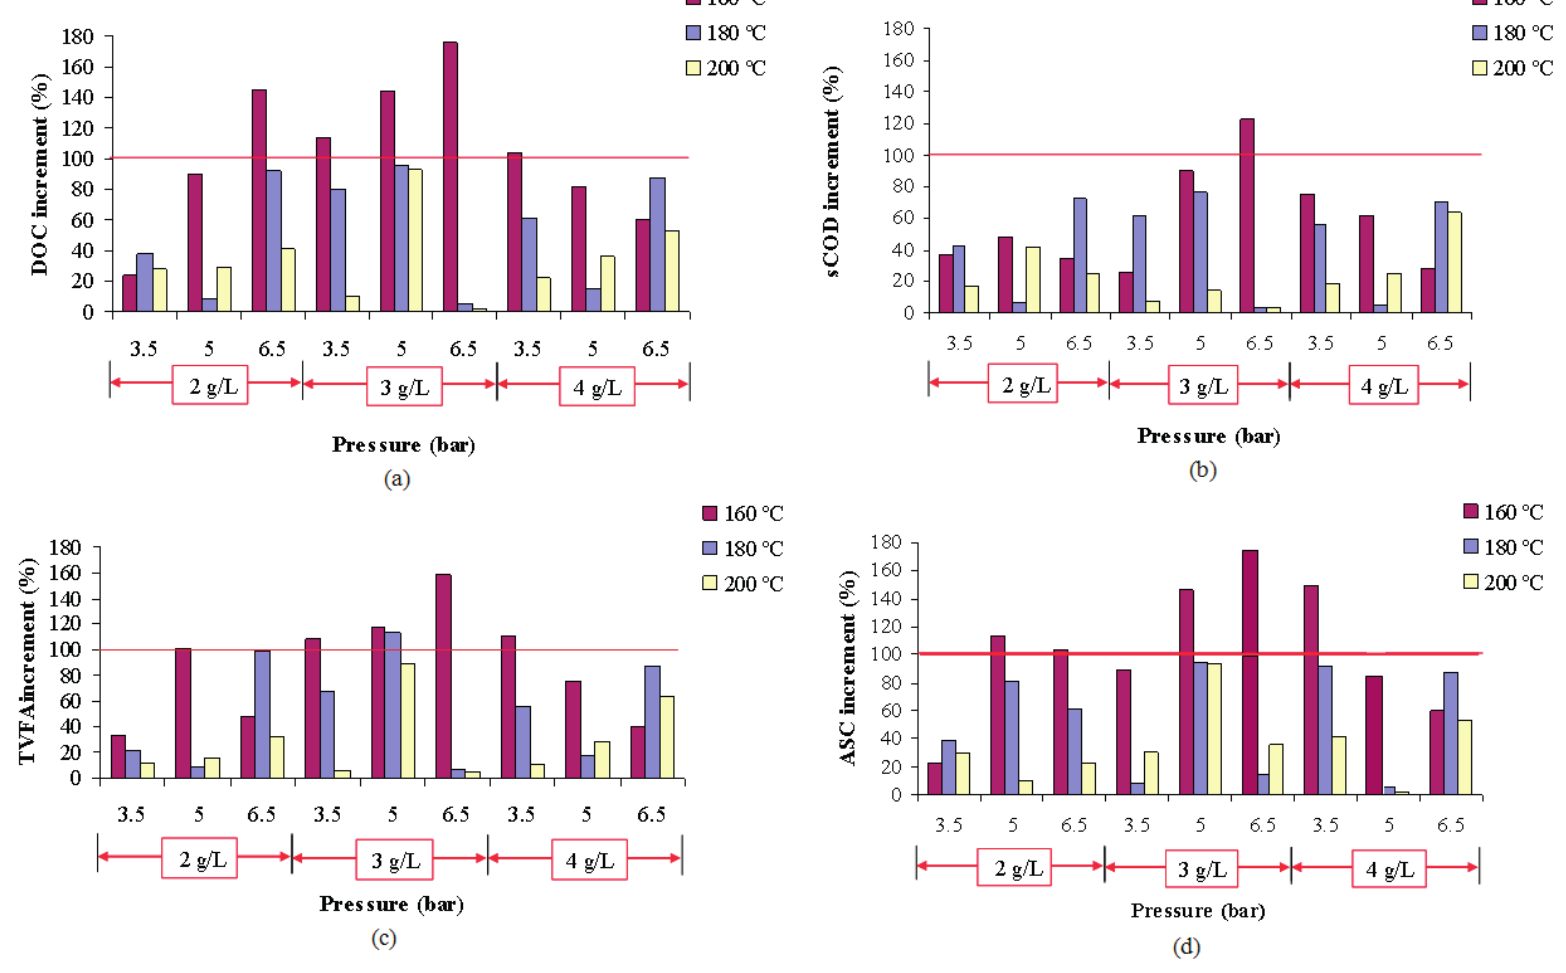
Figure 1. Effect of the temperature on the SY, expressed in terms of DOC ( a ); sCOD ( b ); TVFA ( c ) and ASC ( d ), at different conditions and 30-min operation